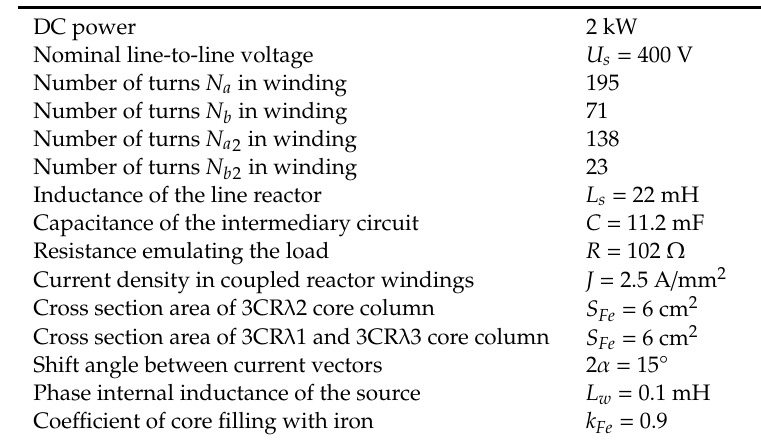
Table 3. Parameters of simulation and laboratory models of the 2 kVA 24-pulse rectifier.